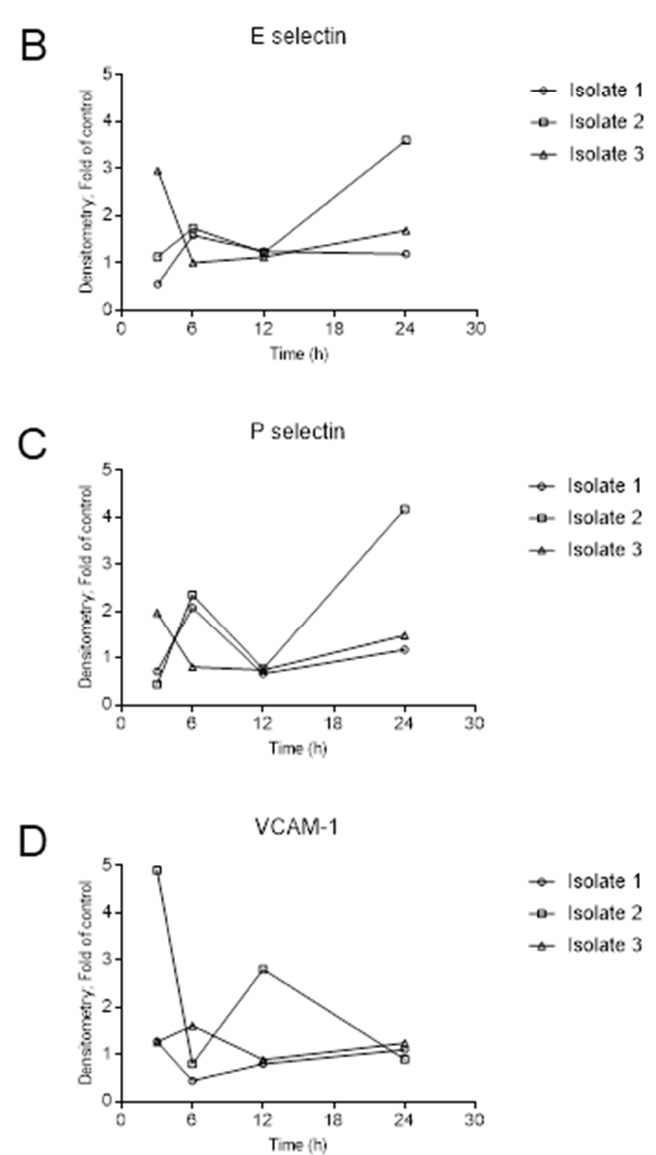
Figure 5. Adhesion molecule protein expression in A. vasorum antigen ( Av Ag)-stimulated canine endothelial cells. CAEC cells were stimulated with A. vasorum L3 antigen ( Av Ag; 1 ng/mL) and after 3, 6, 12 and 24 h of incubation, total protein was extracted. Non-stimulated CAEC served as negative controls. The expression of E-selectin ( B ), P-selectin ( C ) and VCAM-1 ( D ) was studied by Western blotting ( A ); representative illustration of one CAEC isolate and densitometric analysis of protein bands. TNF- α was used as positive control of CAEC stimulation. The detection of vinculin was used as loading control for sample normalization. Complete Western Blot acquisitions from E-selectin, P-selectin, VCAM-1 and vinculin is depicted in the Supplementary Figure S1